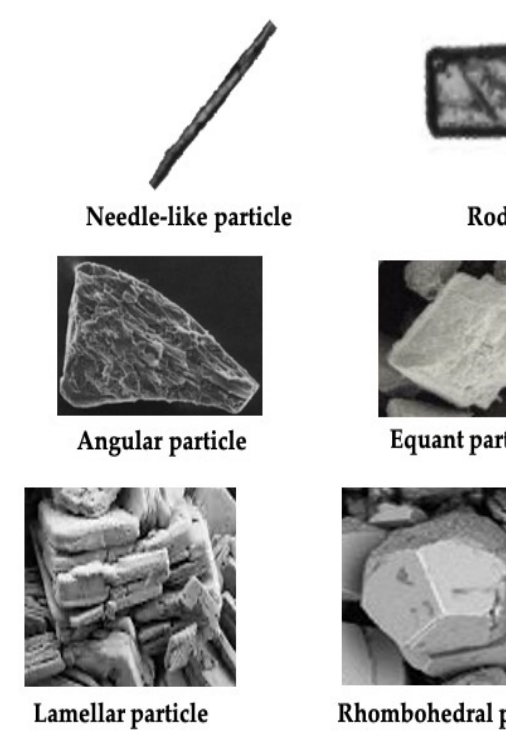
Figure 7. Industrial particles of various shapes.